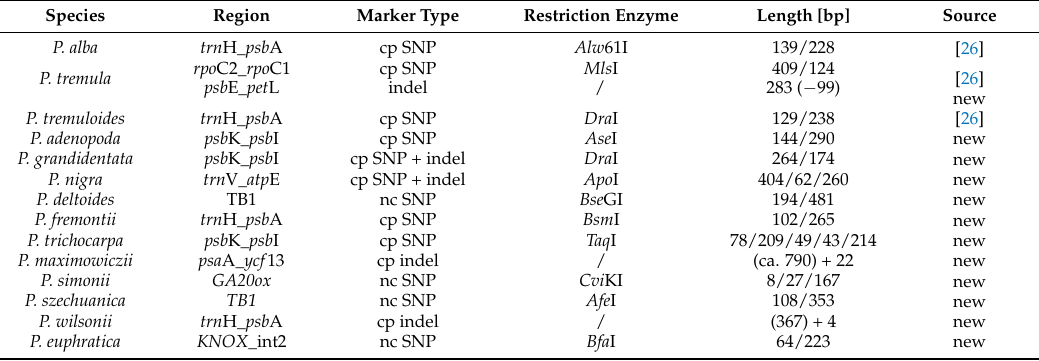
Table 5. Applicable SNP and indel markers. Selection of easy-to-use SNP and indel markers for the identification of 14 poplar species. The column “source” contained the information if the markers are already published or newly designed, and first presented in this study